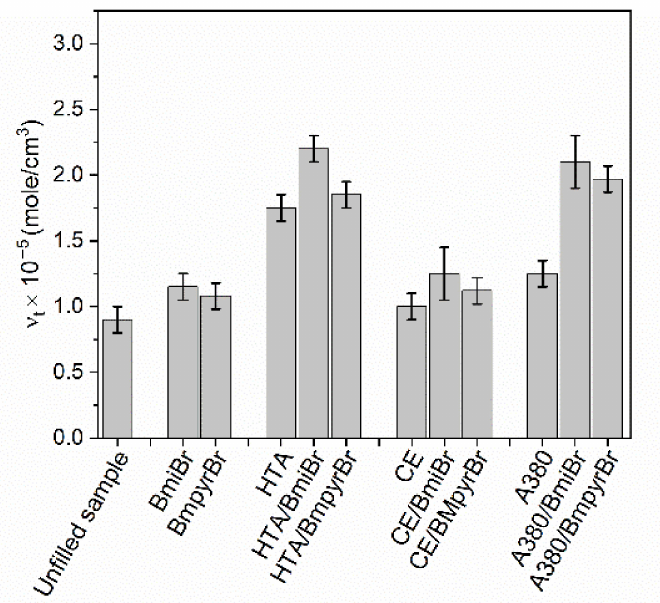
Figure 5. Effect of fillers and ILs on the crosslink density of NR